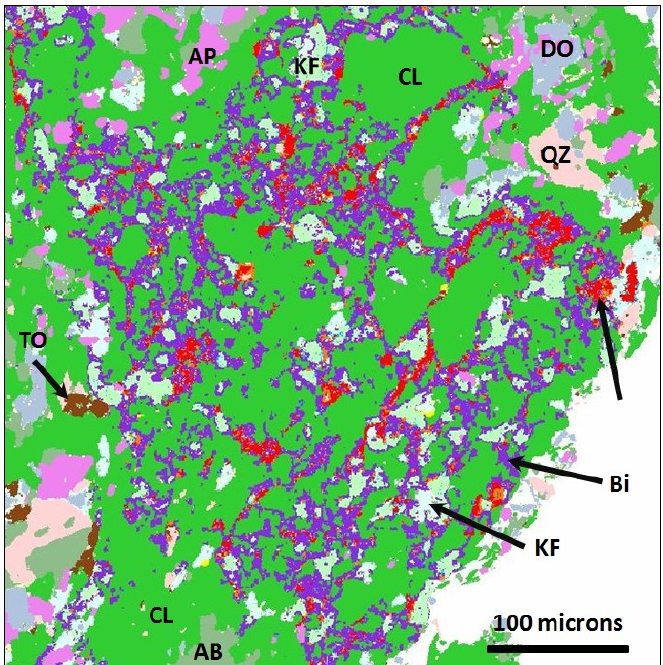
Figure 12. QEMSCAN image showing incipient breccia of chlorite-rich domain with network of biotite and K-feldspar veinlets with brannerite and Ti oxides. SD083 69.2 m. AB, albite; AP, apatite; BI, biotite; DO, ferroan dolomite; KF, K-feldspar; QZ, quartz; TO, Ti oxide. Brannerite is red and sulphide